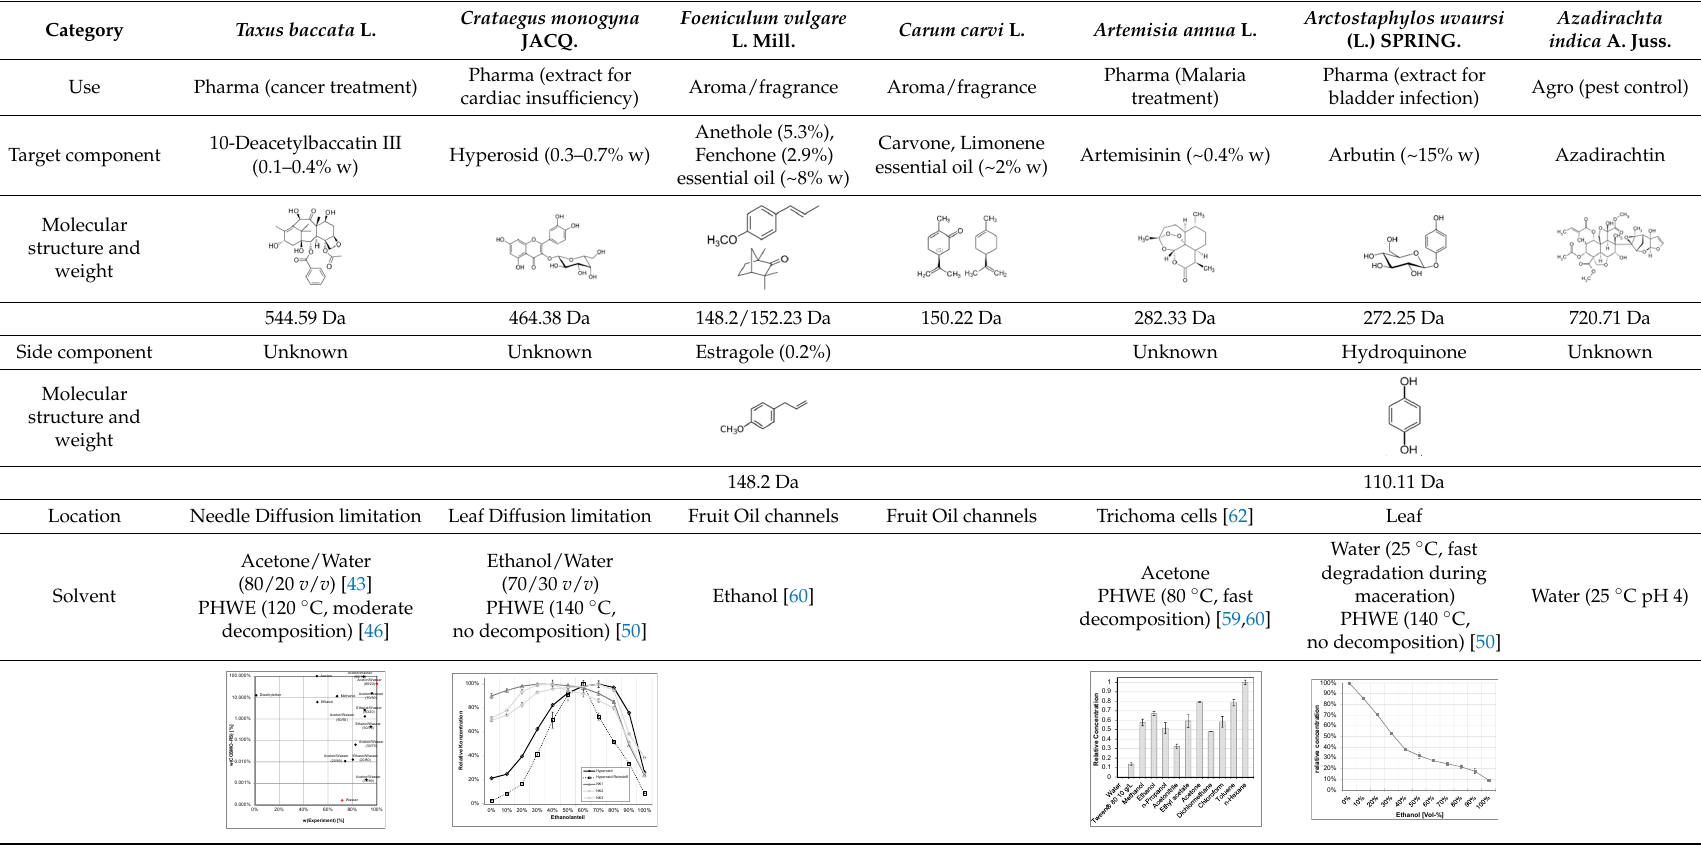
Table 3. Database of the physical properties of various herbal raw material for process design.